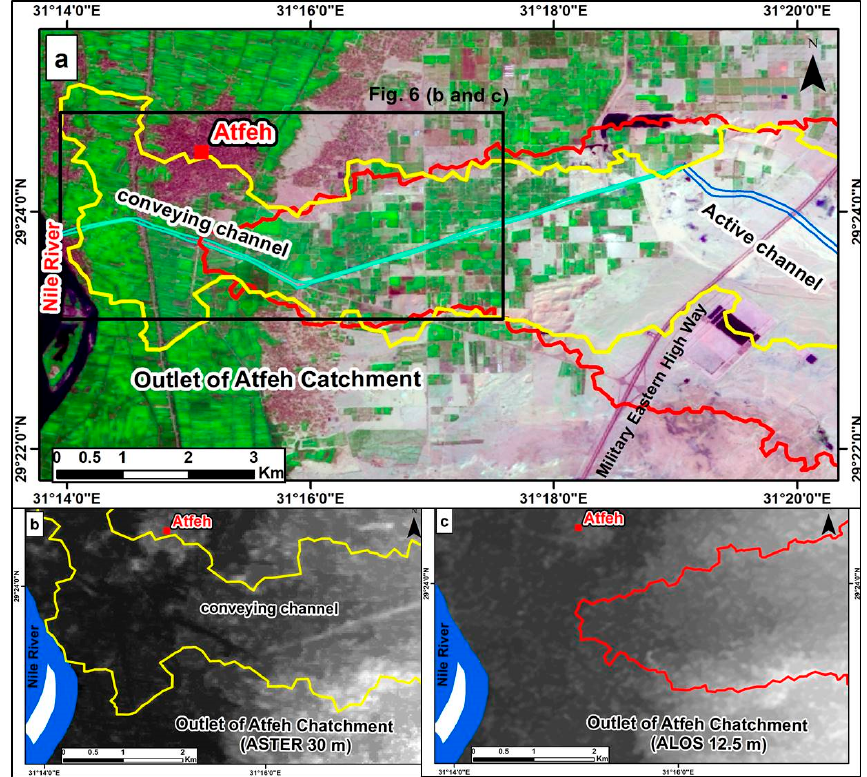
Figure 6. ( a ) Landsat 8 image of the outlet of Atfeh catchment showing the catchment boundary from different DEM sources (ASTER DEM in yellow and ALOS DEM in red) as well as the conveying channel. The relief signature of the man-made conveying channel can be recognized only on the ASTER DEM of 30 m resolution ( b ) but not on the ALOS DEM 12.5 m resolution ( c ). Note that the automatic extraction of the catchment boundary using ALOS DEM yielded a smaller catchment compared to the one derived from the ASTER DEM, where the catchment outlet on the former DEM occur at ~1.5 km away from the Nile River compared to reaching the Nile River on the later (refer to Figure 4 for a regional overview of the two catchments).